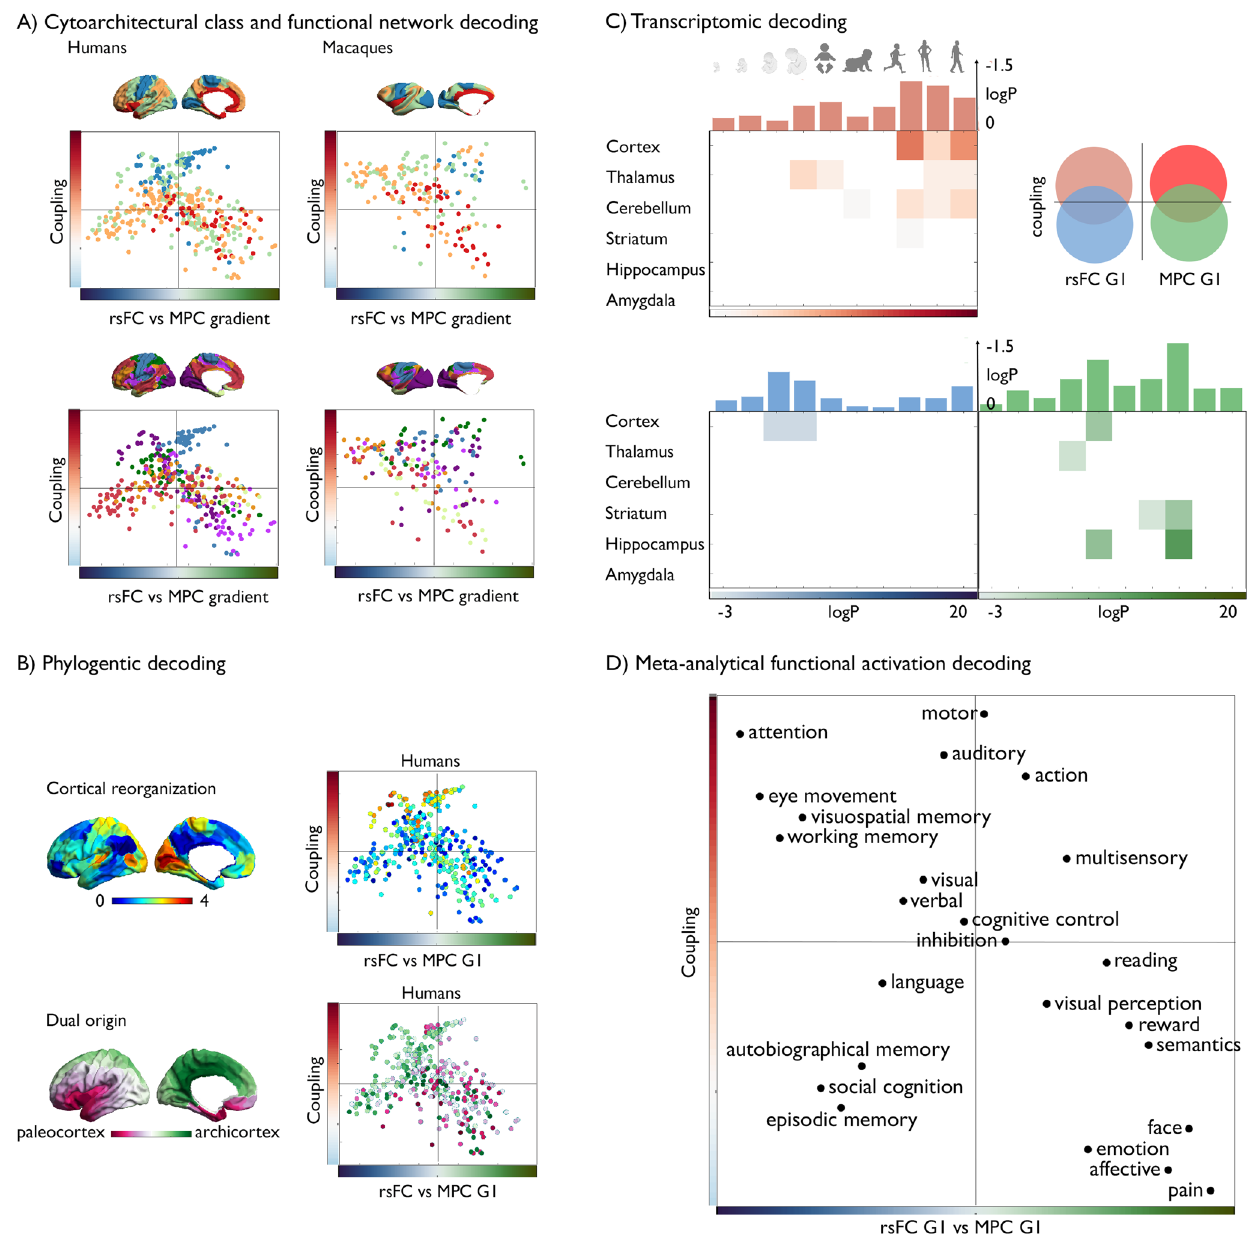
Fig. 7 Multiscale quadrants of structure – function coupling. A Cytoarchitectural class 59 and functional community 28 decoding along 2D model of the difference between microstructural and functional connectivity gradients in humans and macaques ( x -axis) and microstructure-functional connectivity coupling ( y -axes); B Phylogenetic models using cortical reorganization 41 and a model of dual patterning in the cerebral cortex 53 ; C Transcriptomic developmental decoding of coupling and gradient differences between structure and function, Red/Blue/Green tones represent the log transformed false discovery rate (FDR)-corrected p -values [ – 20 – 3]. The bar plot above represents the log transformed (FDR)-corrected p -values, averaged across all brain structures. Red indicates the genes that were attributed to the left upper quadrant, blue indicates the values were higher for the functional end of the difference gradient and untethered, whereas green re fl ects the microstructural apex and untethered. Only values that are below FDRq < 0.05 are displayed; D 2D projection of NeuroSynth meta-analysis 56 of regions of interest along Δ rsFC-MPCG1 map ( x -axis) and structure – function uncoupling ( y -axis) using 24 topic terms. We binned both Δ rsFC-MPCG1 and coupling maps in 20 equally sized bins, averaged the z -scores of meta-analytical activations per bin and ranked their weighted means along the x - and y -axes. Source data are provided as a Source Data fi